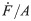
Bulk analysis of gene expression in microfluidic chemostats.(A) Total cell area A in pixels as a function of time for acquisitions with different AHL concentrations. The cells are in exponential growth for at least 450 min. After this time, the bacteria completely fill the microfluidic traps and the measured area stays constant. (B) Total colony fluorescence F as a function of time. (C) Maximum gene expression rates calculated as F˙/A (cf. Eqs 1–3). The solid response curve is a Hill fit to the data with n = 0.95±0.2 and K = 5.3±1.4 nM. (D) Snapshots taken from a time-lapse microscopy video of a bacterial colony growing in a microfluidic trap, which is connected to a supply channel on the right. The images shown are overlays of bright-field and fluorescence data. In the example, the bacteria were induced with 12 nM AHL.